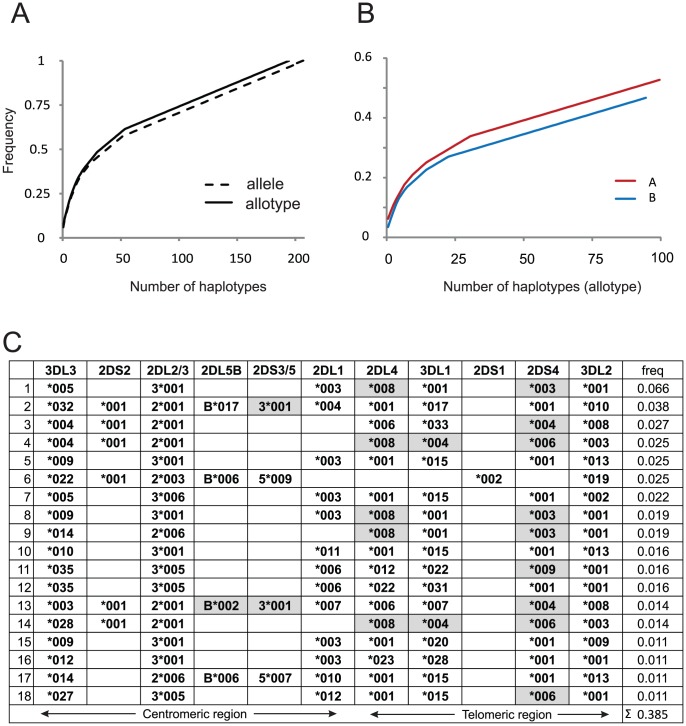
High diversity of functional KIR haplotypes in Ghana.A. Cumulative frequency plot of the high-resolution KIR haplotypes, which have been added in order of decreasing frequency. The solid black line (allotypes) considers only haplotypes that differ at non-synonymous substitutions; the dashed black line (alleles) considers all haplotypes that have a unique nucleotide sequence in the KIR coding regions. All haplotypes are shown in Figure S5. B. Cumulative frequency plot comparing the contributions of A (red line) and B (blue line) KIR haplotypes. The plots are for haplotypes that differ by non-synonymous substitutions. C. Considering only the 195 KIR haplotypes that differ by non-synonymous substitutions, the panel shows the structures of the 18 allotype-level KIR haplotypes that have frequencies >1% in the Ga-Adangbe. Grey indicates an allotype that is likely not expressed on NK cell surfaces, because of deleterious mutation (see Figure S4). The estimated mean KIR haplotype length is 142 kb with an average 6.5 expressible genes (min 3, max 11).